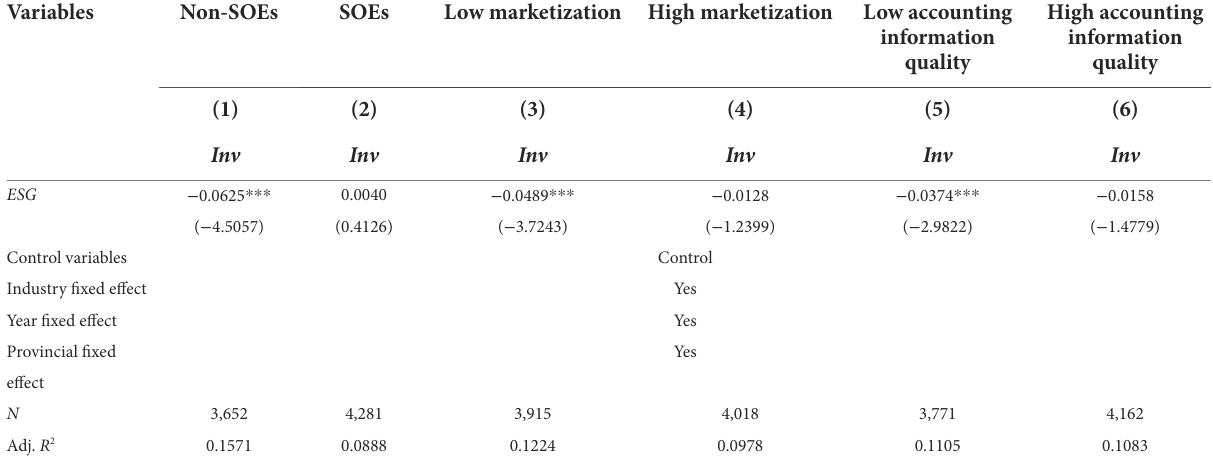
TABLE 12 Results of grouped